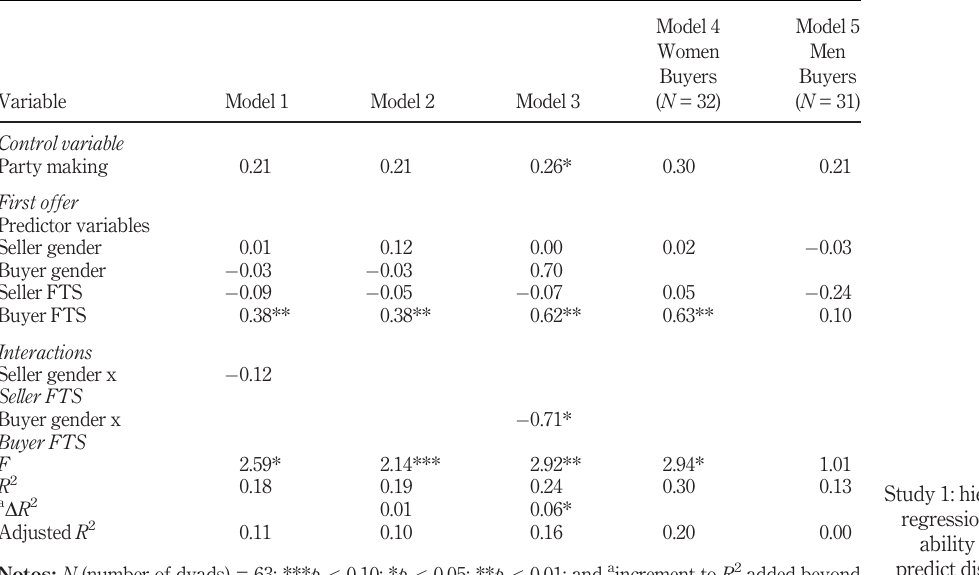
Table 2. Study 1: